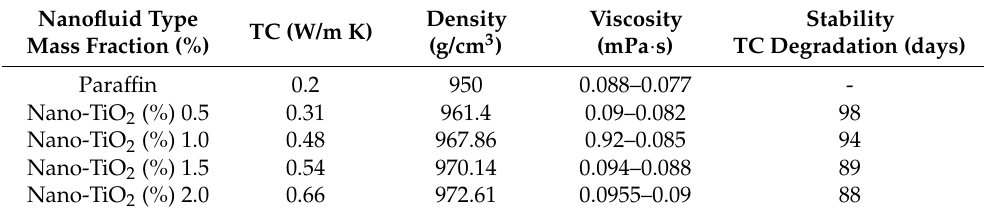
Table 7. The thermophysical properties of tested nano-paraffin at 65 ◦